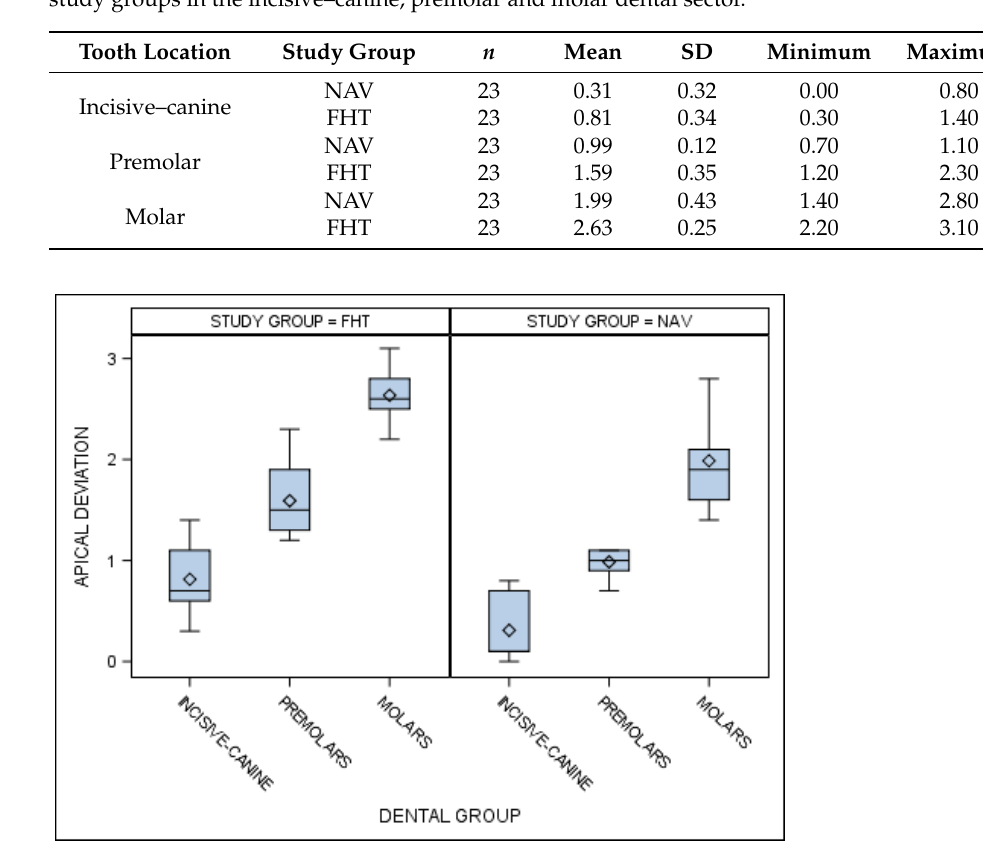
Figure 8. Box plot of the apical end-point deviations of the orthodontic micro-screws placed using the computer-aided static navigation technique and conventional freehand technique in the incisive–canine, premolar and molar dental sectors.